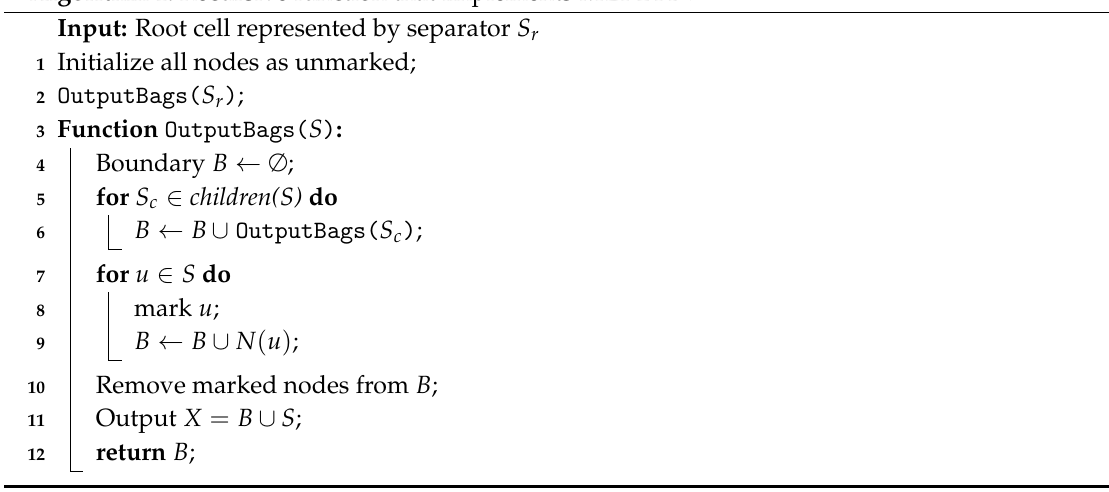
Algorithm 1: Recursive function that implements MLP2TD.